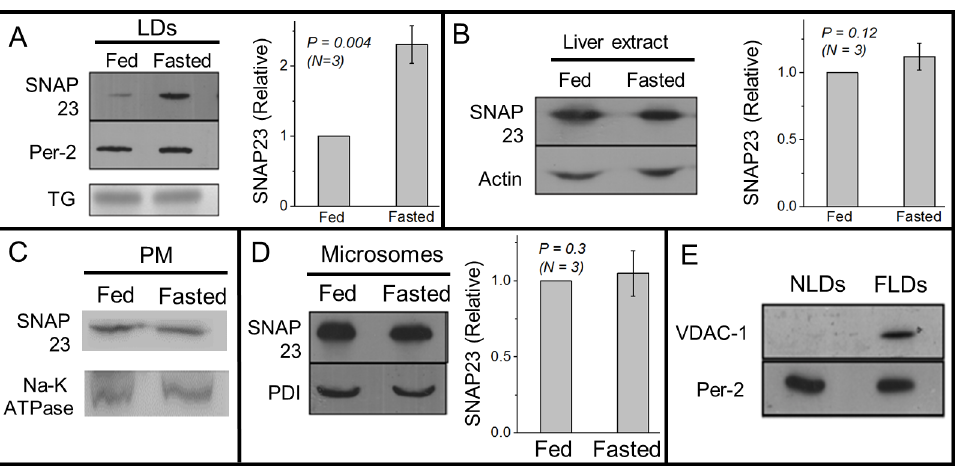
Fig 4. SNAP23 association with LDs, plasma membrane and microsomes across feeding-fasting transition. (A) Western blottingagainst SNAP23 on NLD and FLD samples shows more SNAP23 on FLDs as compared to NLDs. Equal amount of NLDs and FLDs were used, as confirmed from equal intensity of perilipin-2 band by Western blotting and by TG band intensity in a TLC experiment. The experiment was repeatedon three pairs of fed and fasted animals. Relativeintensity of SNAP23 normalisedto perilipin-2levels has been used for statistical analysis. Error bars are SEM. (B) SNAP23 levels do not show significantchangein liver extract preparedfrom fed and fasted rats. Actin was used as loadingcontrol. This observation was seen consistently in samples preparedfrom three pairs of animals. Error bars are SEM. (C) No significantchangeis observedin SNAP23 levels on PM-enrichedfractions betweenfed and fasted states. Western blotting againstNa-K ATPase (PM marker) was done to ensureequal loadingof samples. (D) No significantchangeis observedin SNAP23 levels on microsome fractions betweenfed and fasted states. Western blotting againstPDI shows equal loading of both the samples. Error bars are SEM. (E) Western blotting againstVDAC-1 (mitochondria marker) on NLD and FLD samples. VDAC-1 is detected only on FLDs. This experiment was repeatedon LD samples isolated from two pairs of fed and fasted animals.